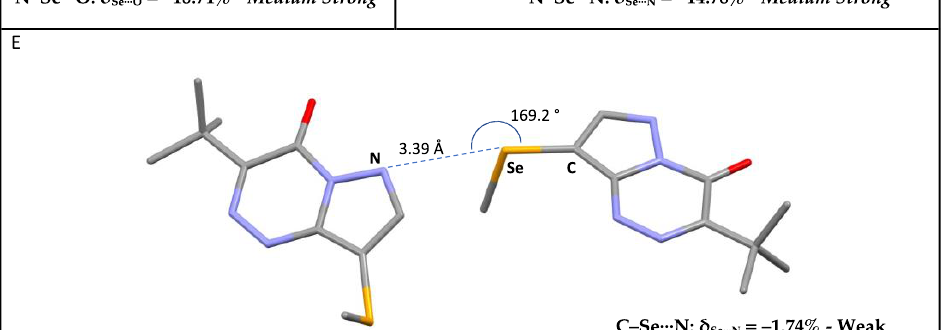
Figure 5. Examples of selected R – Se···A fragments featuring a chalcogen bond and corresponding CCDC refcodes: ( A ) GESSEG; ( B ) FEYBAP; ( C ) SAJPAY; ( D ) GEFVOC10; ( E ) XUBFOS01. MW: medium-weak; MS: medium-strong; S: strong. Atom colors: C (gray); N (blue); Oxygen (red); S (yellow); Se (orange).